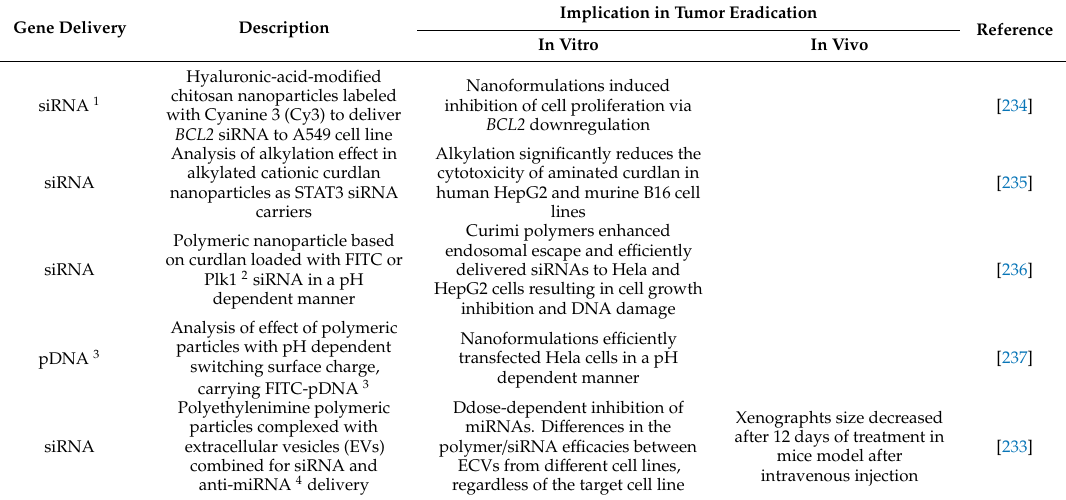
Table 4. Polymeric nanoparticles used in cancer